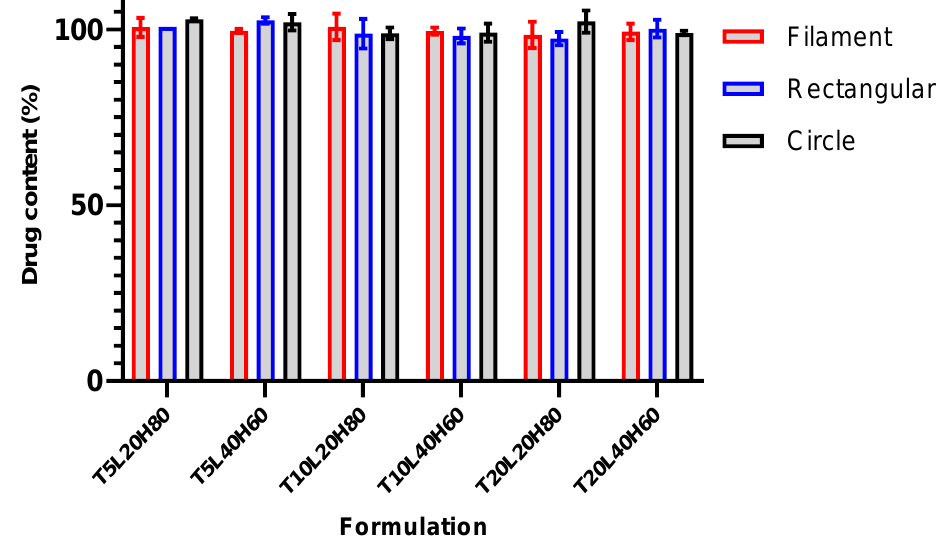
Figure 6. Results of drug content analysis of TA-loaded PCL implants. Data presented as mean ± SD, n =